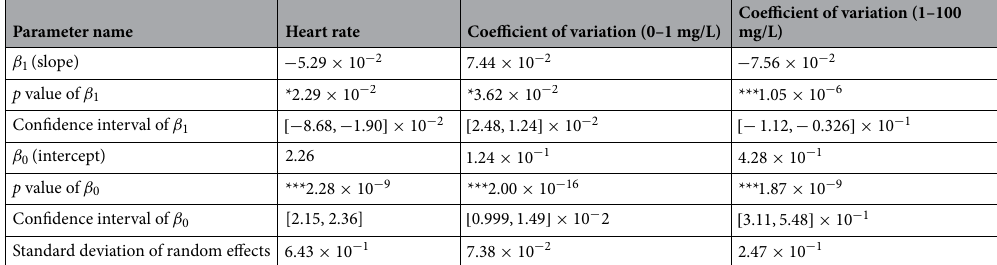
Table 2. Linear mixed model analysis for heart rate indices under restraint conditions. (*: p < 0.05 , **: p < 0.001 , ***: p < 0.001 ).